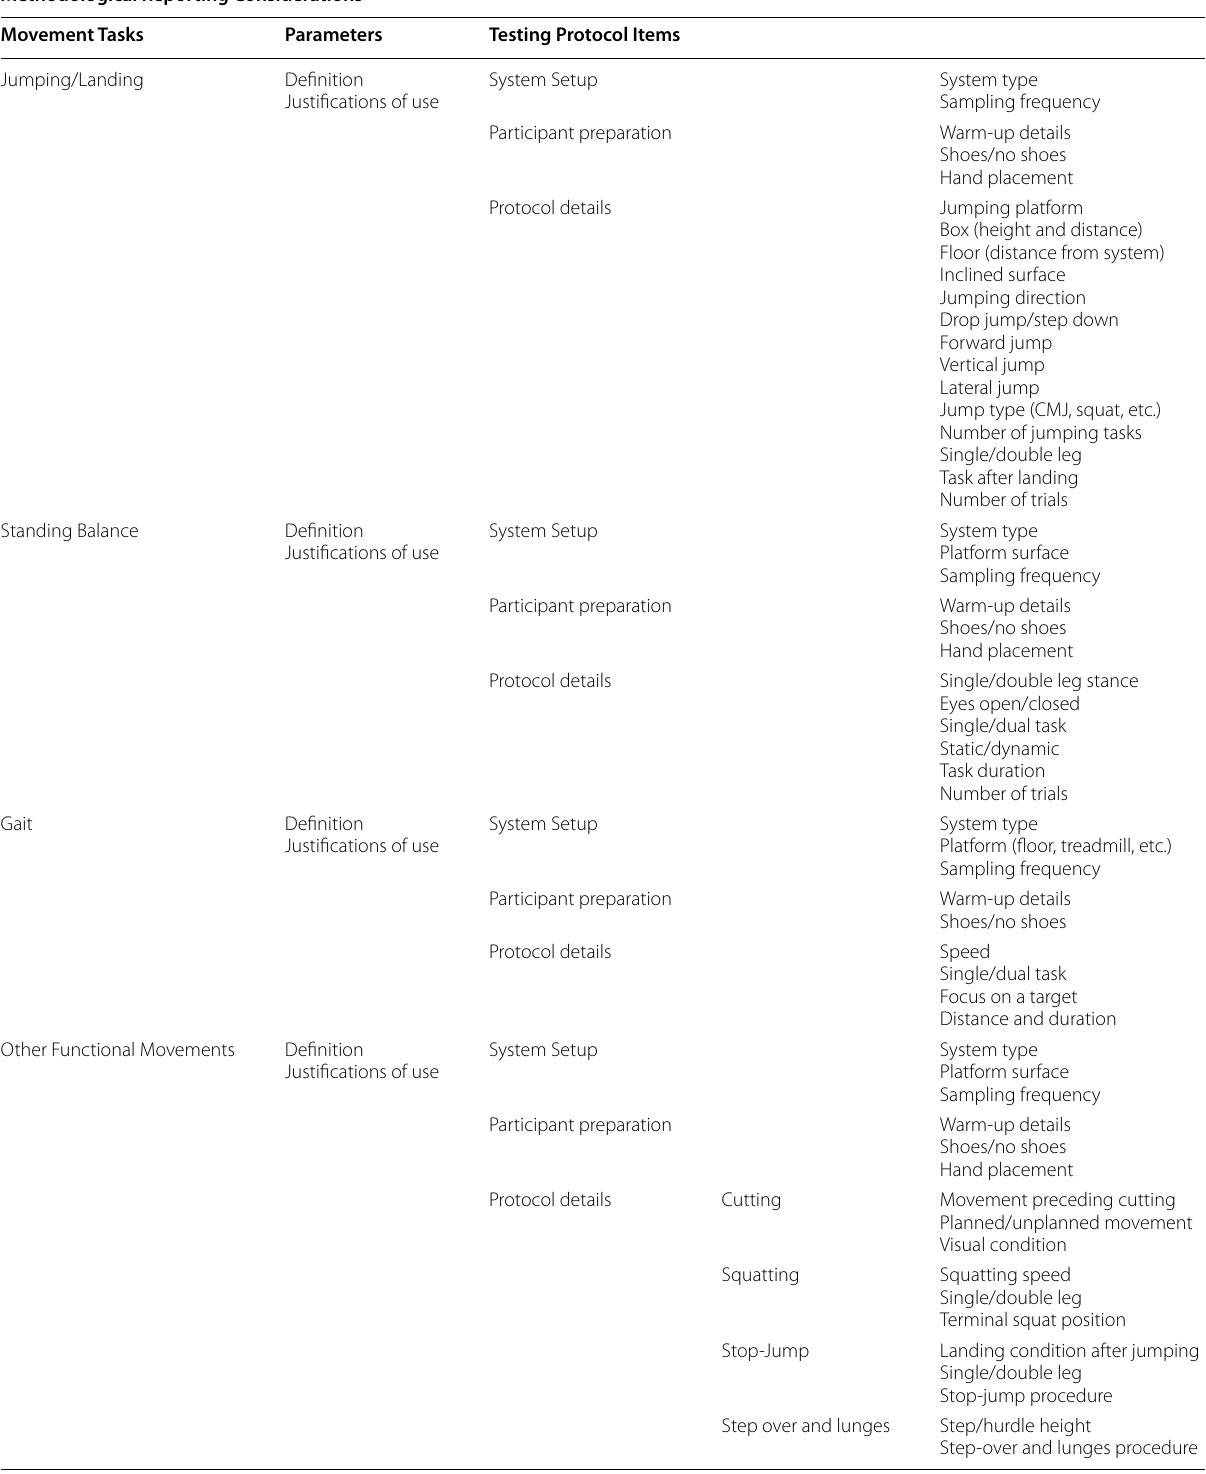
Table 7 Methodological Reporting